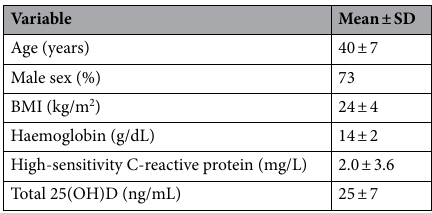
Table 1. Clinical features of the study population.